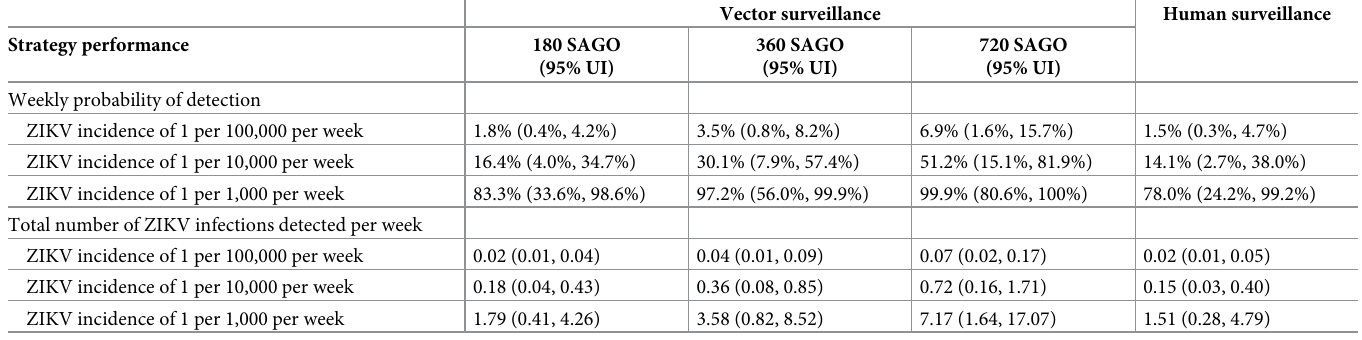
Table 2. The probability of detecting local transmission of Zika virus and the total number of Zika virus infections detected by testing Aedes aegypti pools collected from CDC sentinel autocidal gravid ovitraps and emergency department patients with two or more Zika virus symptoms. Vector surveillance